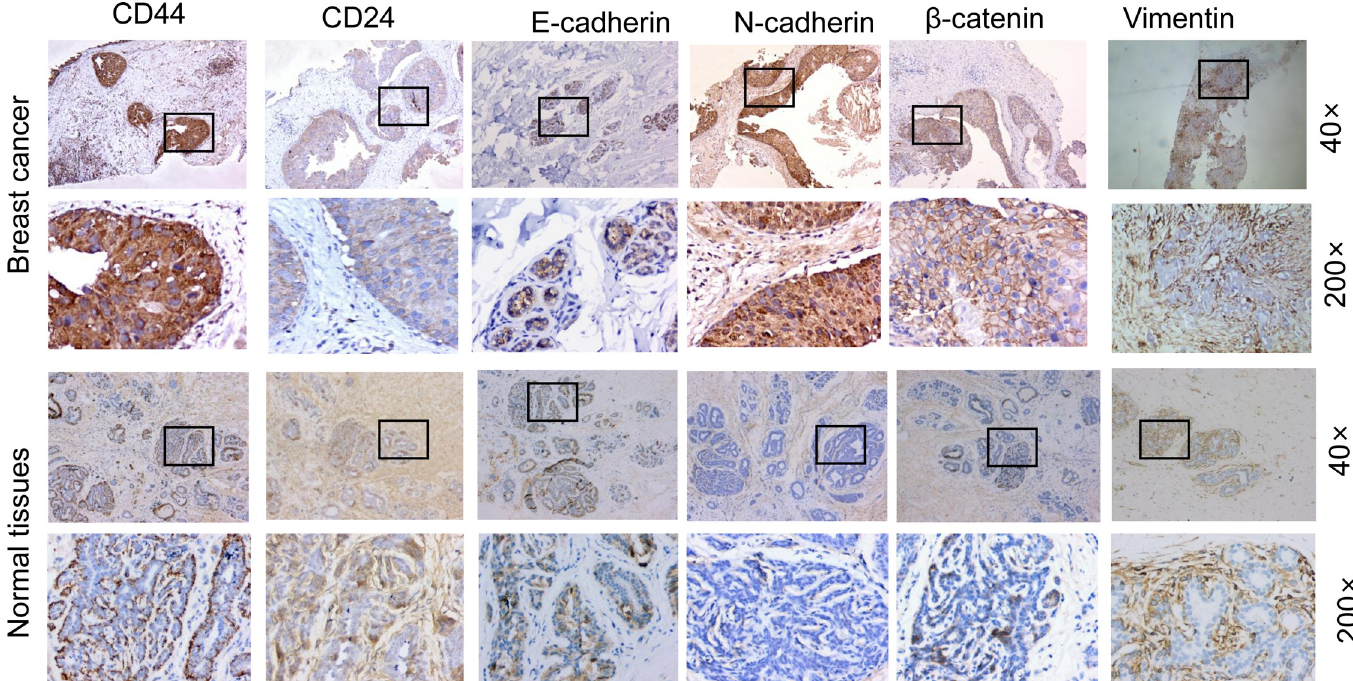
Fig 2. Epithelial-mesenchymal transition (EMT) of breast cancer stem cells. The expression levels EMT-related factors were detected with immunohistochemistry (Magnification 200 × and 40 × ), including the CD44 (4 vs 2 points for the breast cancer and normal surrounding tissue groups, respectively), CD24 (2 vs 4points), E- cadherin (1 vs 3 points), N-cadherin (4 vs 0 points), β -catenin (3 vs 1 points), and Vimentin (3 vs 3 points).